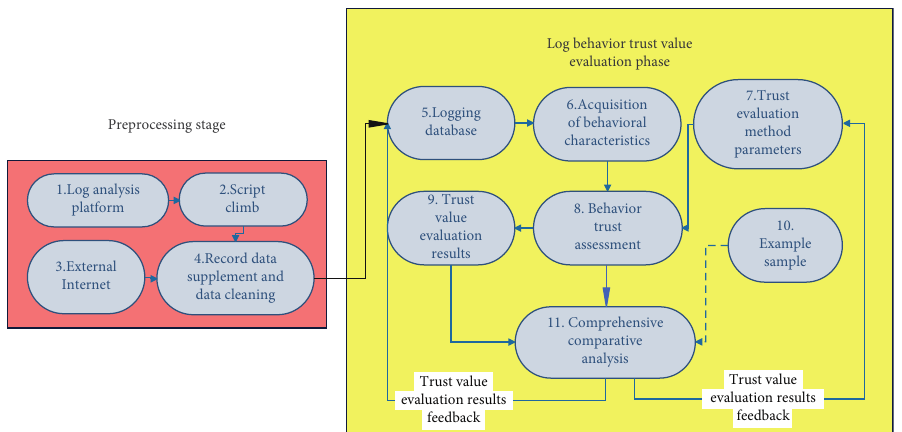
Figure 7: Flowchart of analysis model based on log behavior.